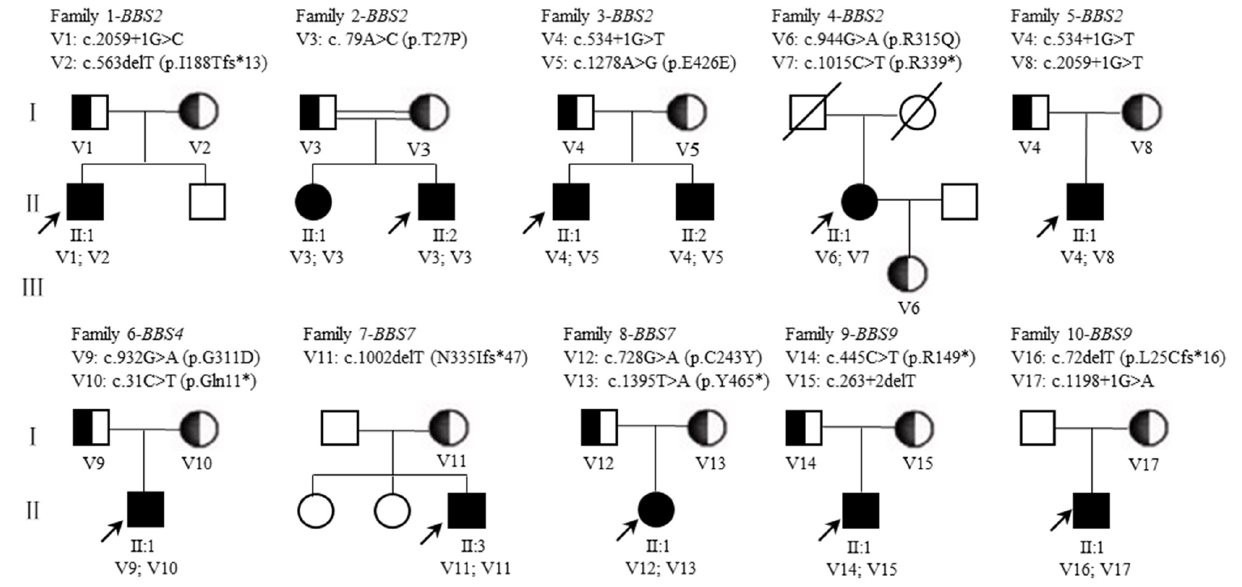
Frontiers in Cell and Developmental Biology |